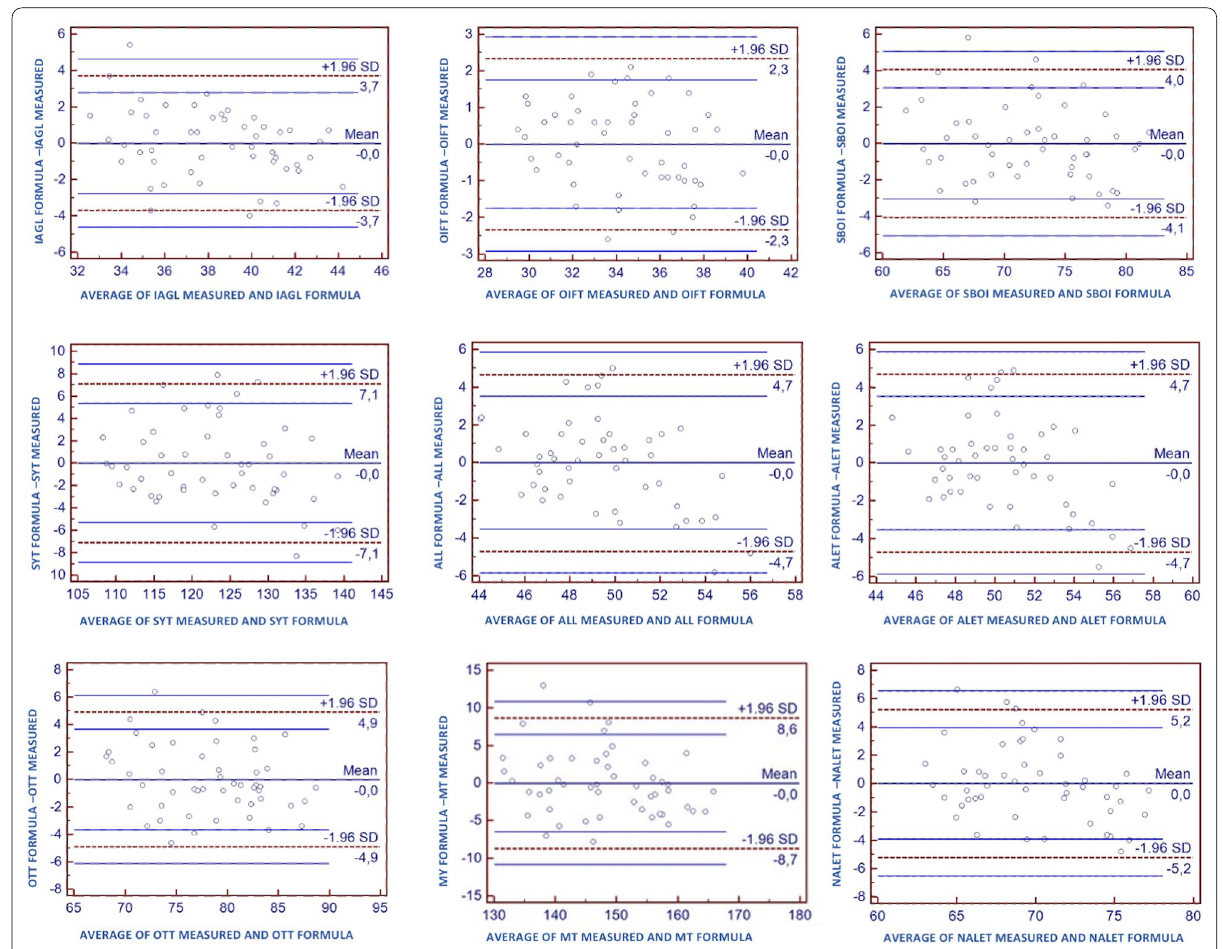
Fig. 4 Bland–Altman plots to compare 3D measurements performed on the MRI and calculated with the formulas. IAGL Intrarticular length of the graft, OIFT outside-in femoral tunnel, SBOI single bundle outside-in anatomic ACL reconstruction, ALL anatomic anterolateral ligament, ALET modified Lemaire lateral extrarticular tenodesis, anatomical on the femur, SYT Saragaglia and Yamaguchi technique, OTT over the top femoral position ACL reconstruction, MT Marcacci technique, NALET modified Lemaire lateral extrarticular tenodesis, SD standard